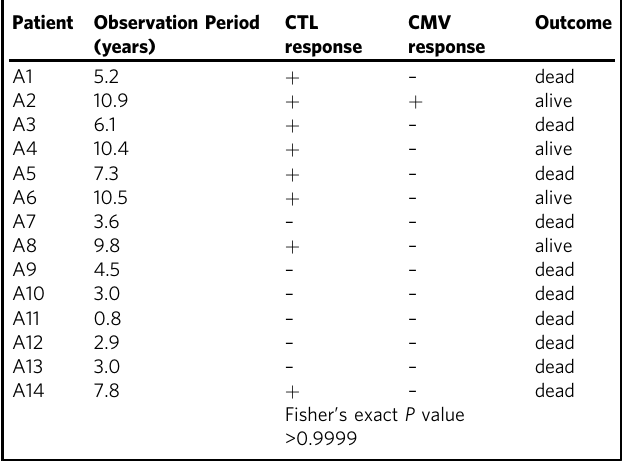
Table 1 Individual survival data of the hTERT peptide vaccine trial.